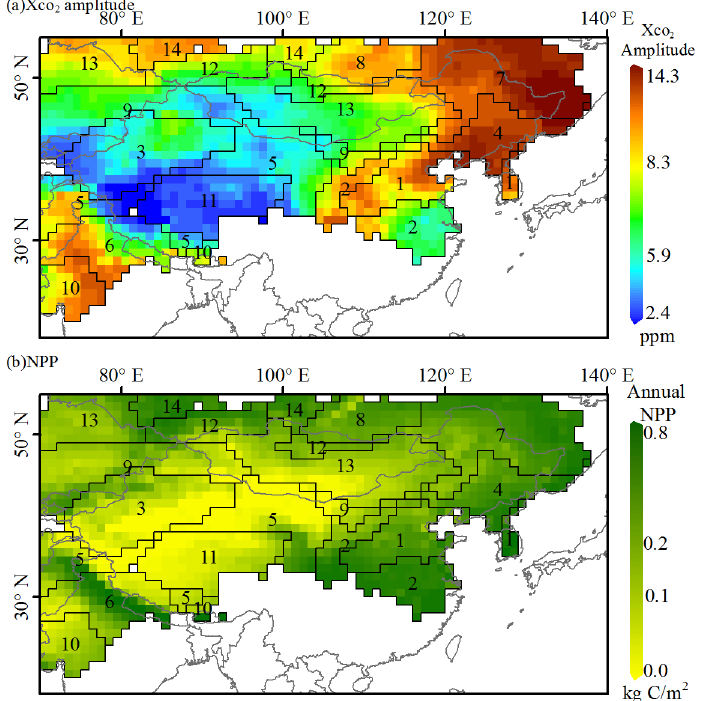
; ( b ) grid map of annual NPP in 2010 overlapped 2